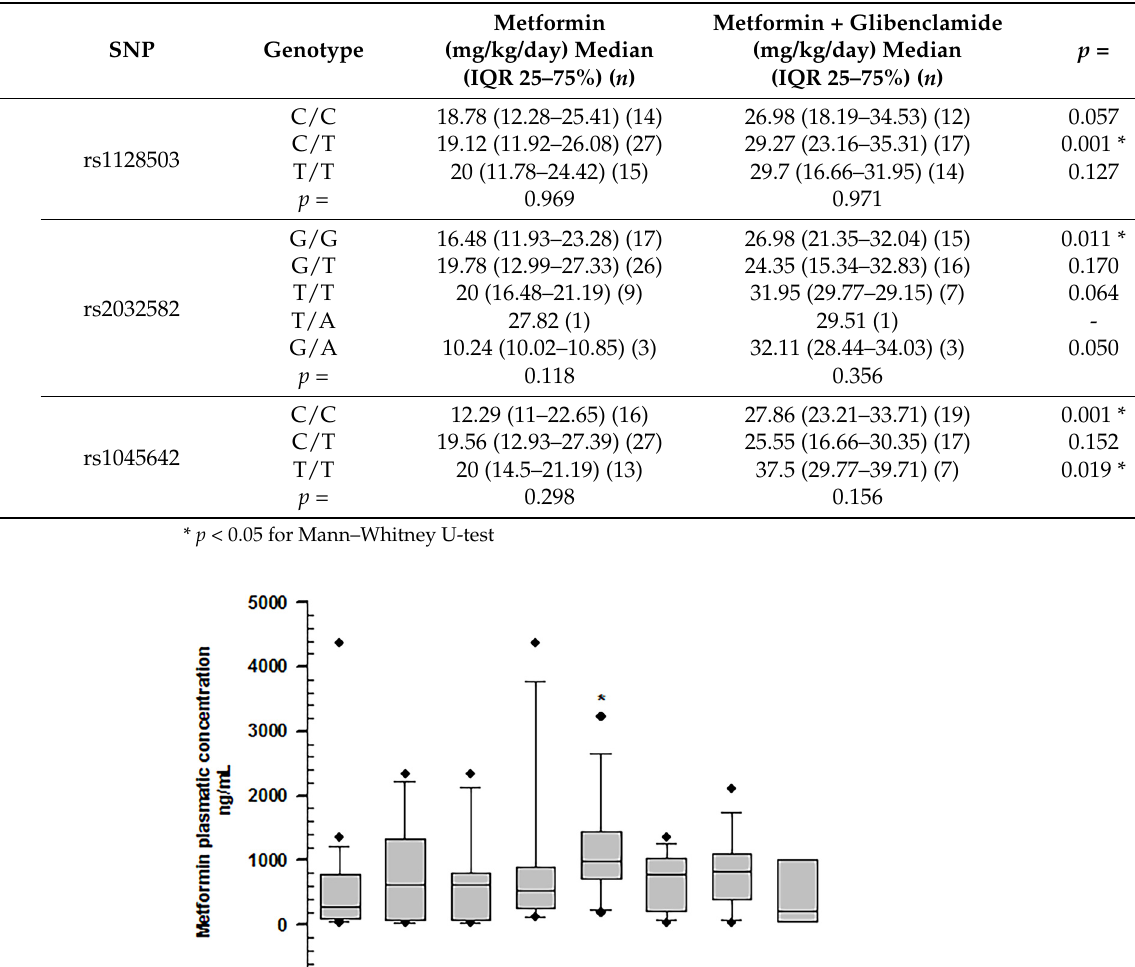
Table 8. Daily metformin dose mg/kg/day according to treatment and genotype.